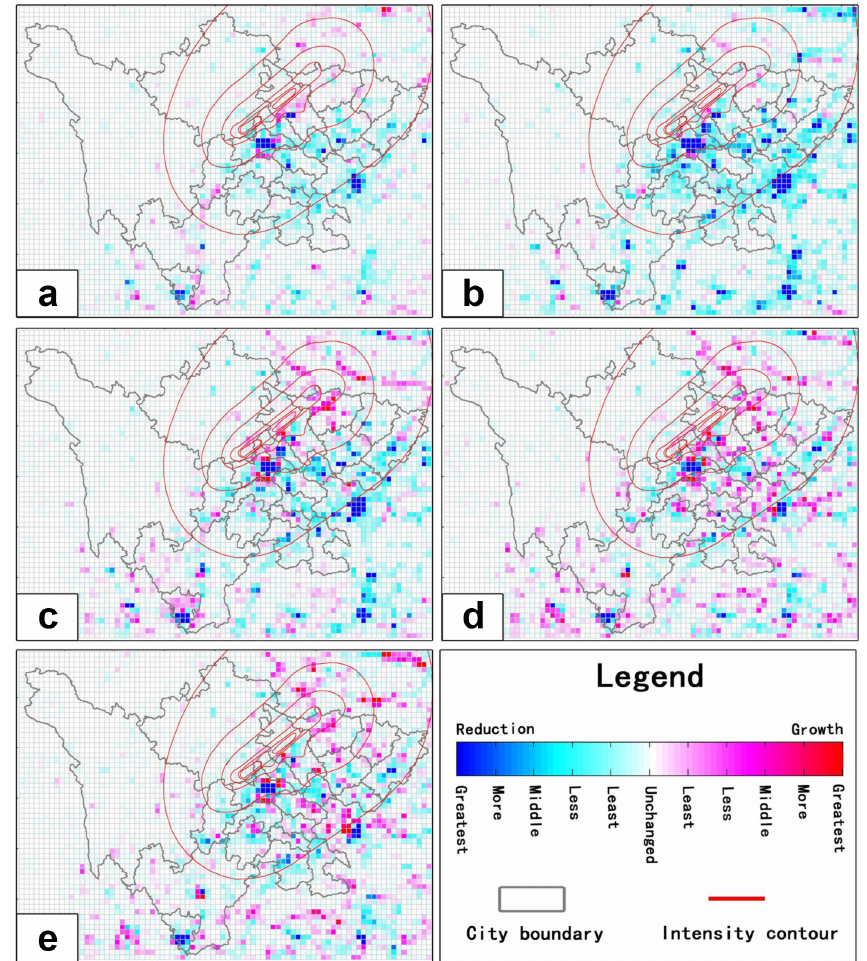
Figure 14. The economic change path in the disaster area: (a) the path of 2008, (b) the path of 2009, (c) the path of 2010, (d) the path of 2011, (e) the path of